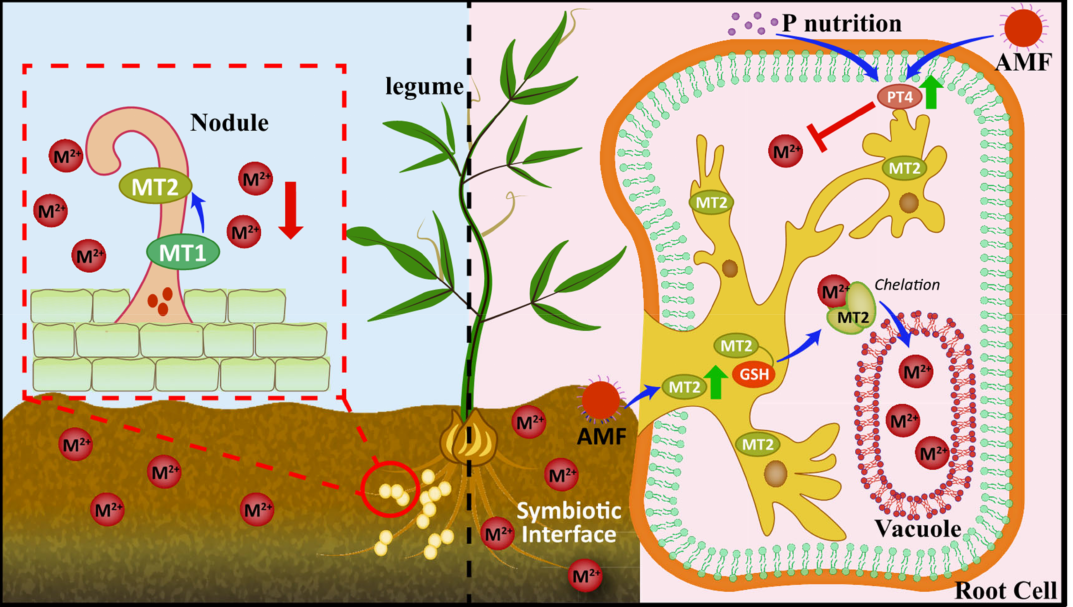
Figure 5. Brief overview of the mechanisms by which MTs enhance plant tolerance to TMs. MT1 and MT2 enhanced the tolerance of root nodules to TMs. At high content of As, AMF enhanced plant phosphorus (P) nutrition, promoted the expression of phosphorus transporter PT4, thereby inhibiting toxic metal ions, and stimulated the expression of MT2 and GSH in plant roots, sequestering more As in roots, and reducing As translocated into root cell vacuoles for storage and detoxification. The red spheres indicate metal ions. MT1 and MT2 denote